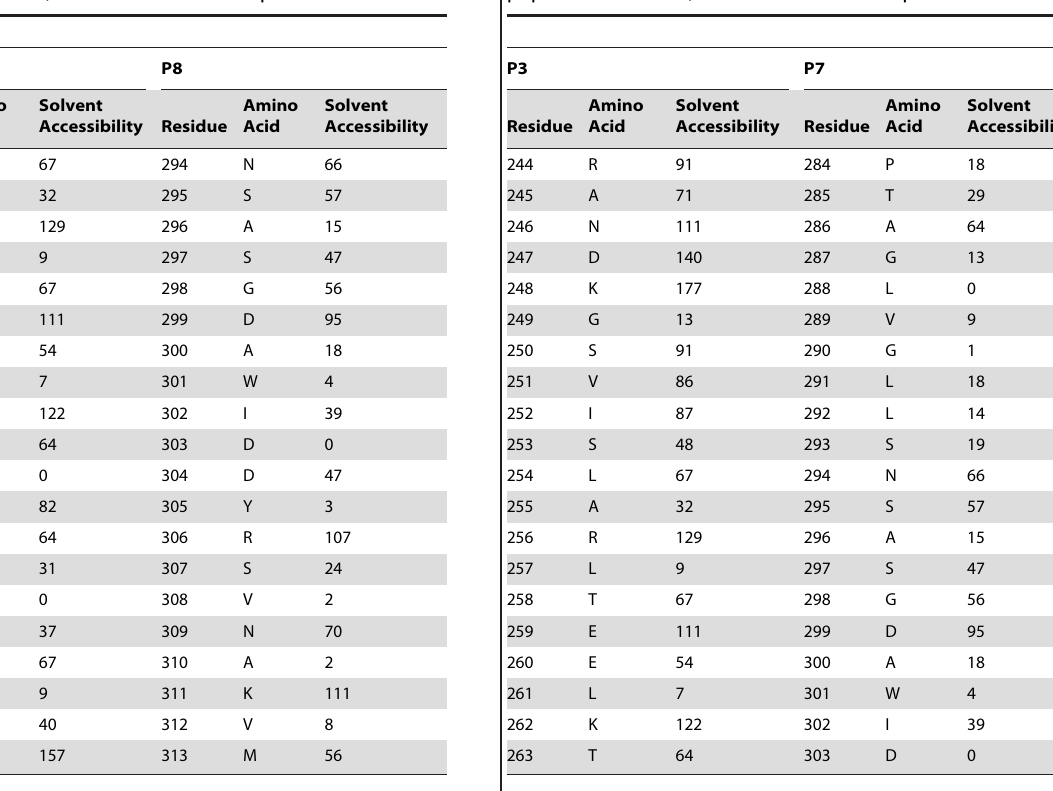
Table 1. The solvent accessibility of the residues from peptides P4 and P8, measured in water exposed surface in A˚ 2 .